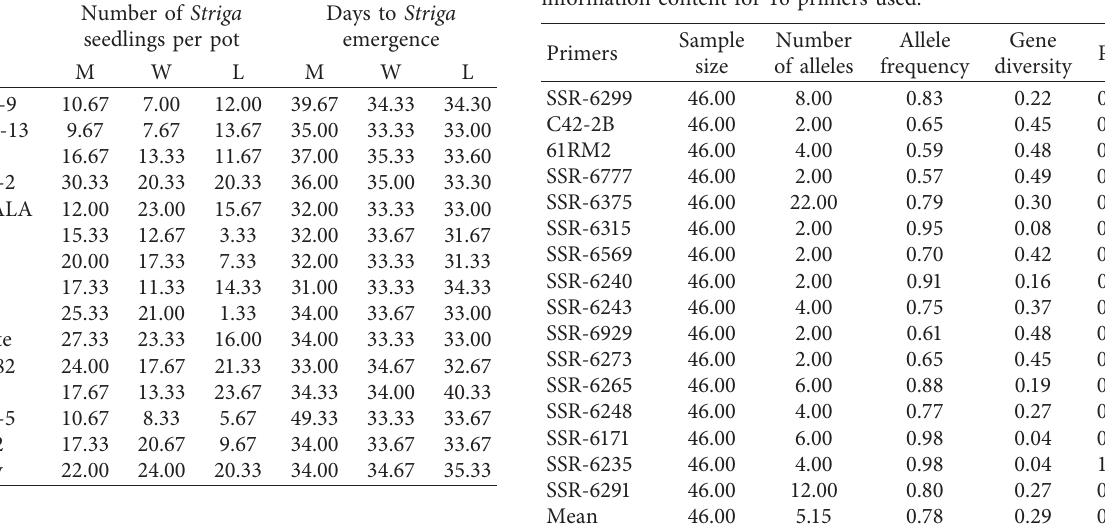
Table 4: Number of alleles, gene diversity, and polymorphism information content for 16 primers